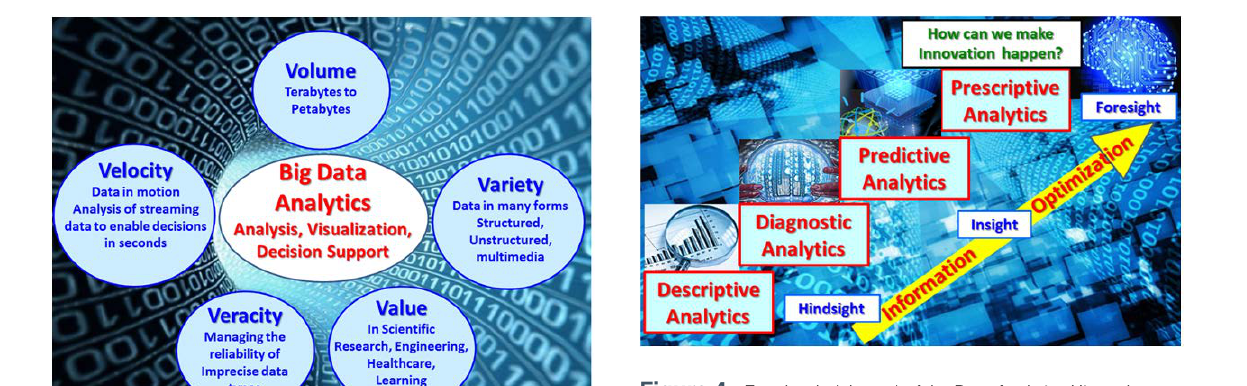
programmable objects, able to construct, and/or decon- struct themselves. For example, car’s surface that change color, tires that adapt to different terrains, or self-heal.